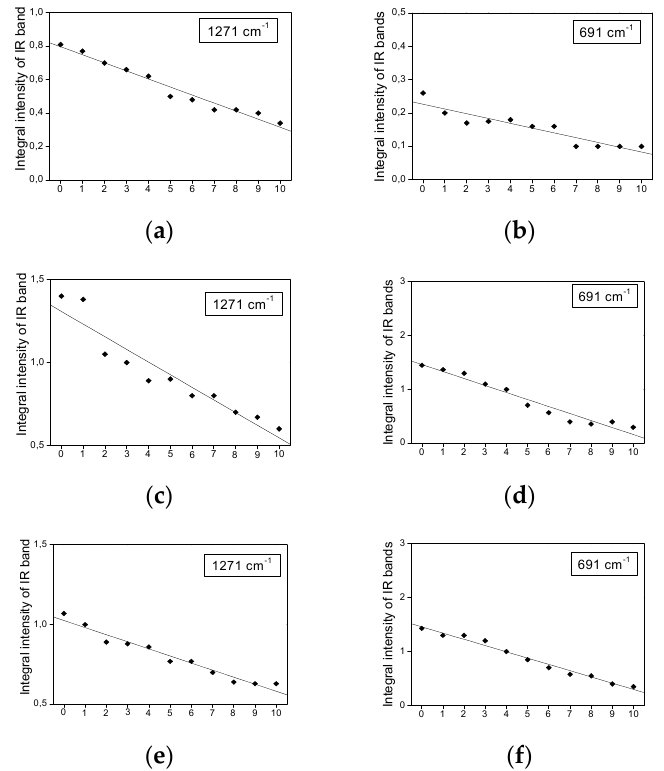
Figure 8. The dependence of the band intensity at 1271 and 691 cm − 1 vs. heating-time, observed in the IR spectra of palm ( a , b ), rice bran ( c , d ), and rapeseed ( e , f ) oils. The regression coefficients for the band at 1271 cm − 1 are from − 0.08 (rice bran oil) to − 0.05 (rapeseed oil) and, for the band at 691 cm − 1 , from − 0.13 (rice bran oil) to − 0.02 (palm oil).